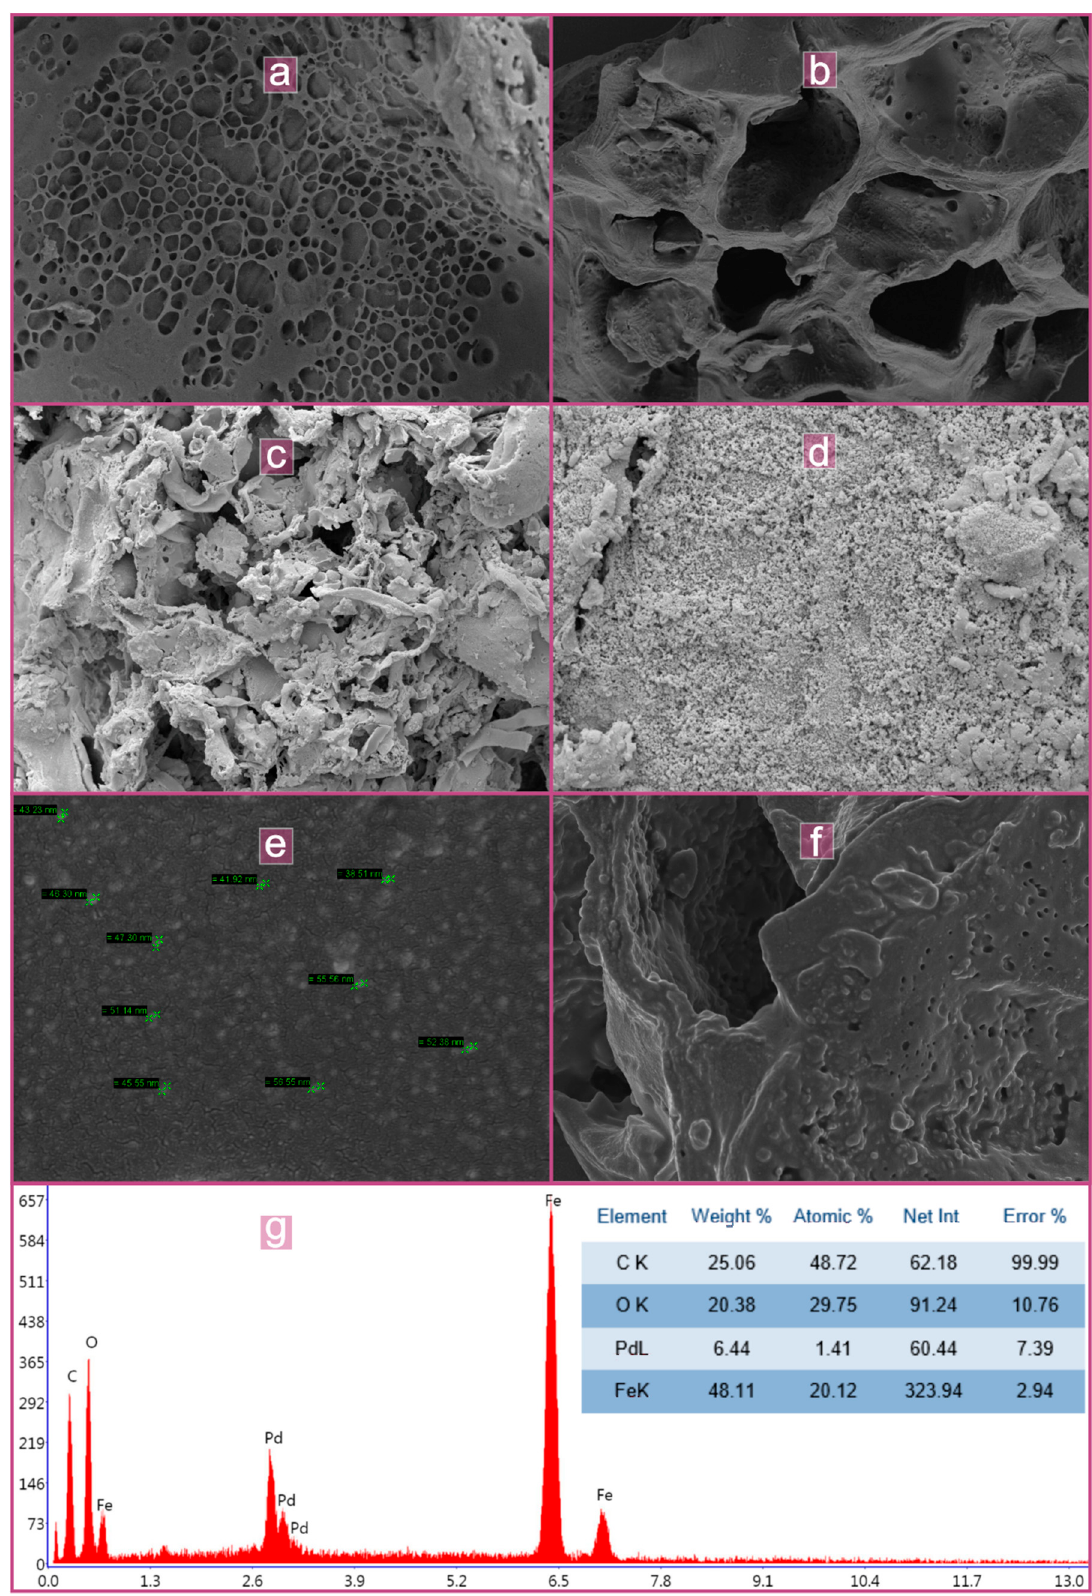
Figure 2. FE-SEM images of CWH ( a – b ), Fe 3 O 4 –CWH ( c – d ), Pd-Fe 3 O 4 -CWH nanocatalyst ( e – f ) and EDS spectrum of Pd-Fe 3 O 4 -CWH nanocatalyst ( g ).